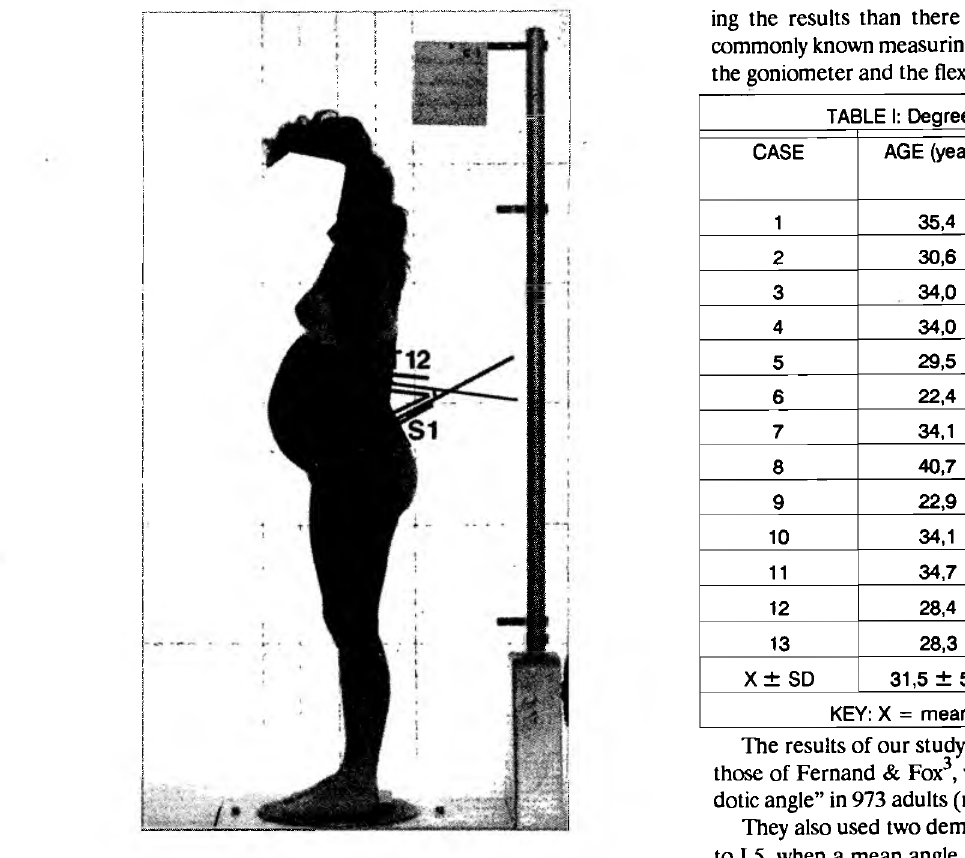
FIG 1: Measurement of the degree of lumbar spine curvature The primed photographs were used to calculate the angles of lumbar spine curvature in each subject. The points marking the spinous processes of T12 and LI, then L5 and SI were joined with straight lines on cach of the photographs (Fig. 1). Perpendicular lines